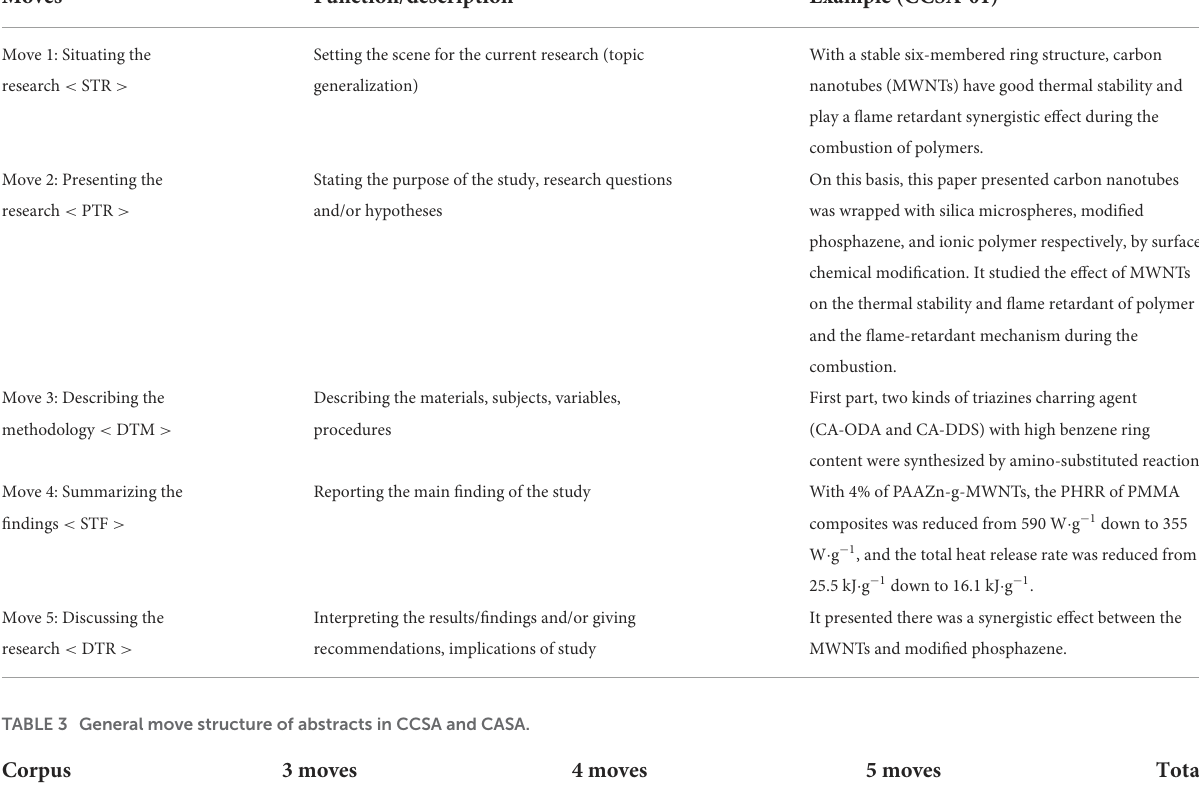
TABLE 2 Santos (1996) framework for move structure.